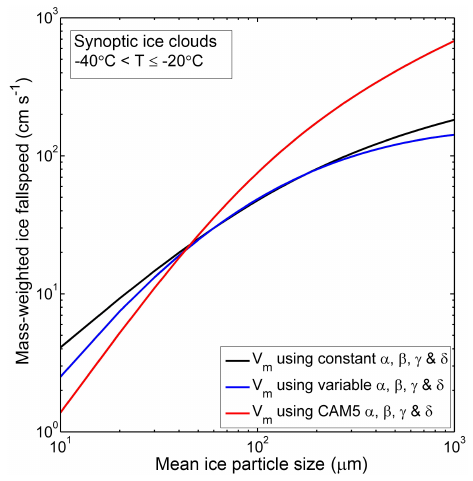
Figure 14. Same as Fig. 13 but for the dependence of V m on D